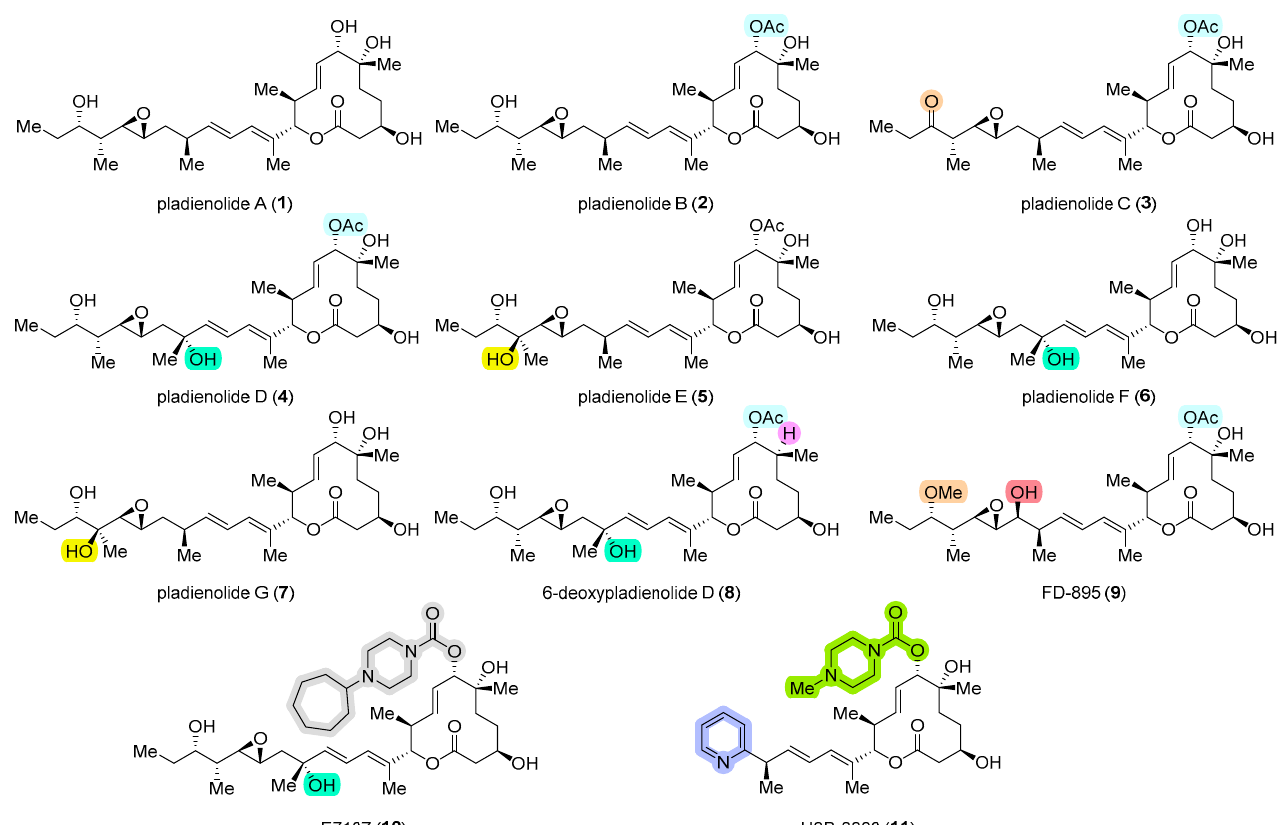
Figure 2. Chemical structure of pladienolides A–G ( 1 – 7 ), 6-deoxypladienolide D ( 8 ), FD-895 ( 9 ), and synthetic analogs ( 10 and 11 ). The colors show the part of each compound that is structurally different from the structure of pladienolide A ( 1 ).